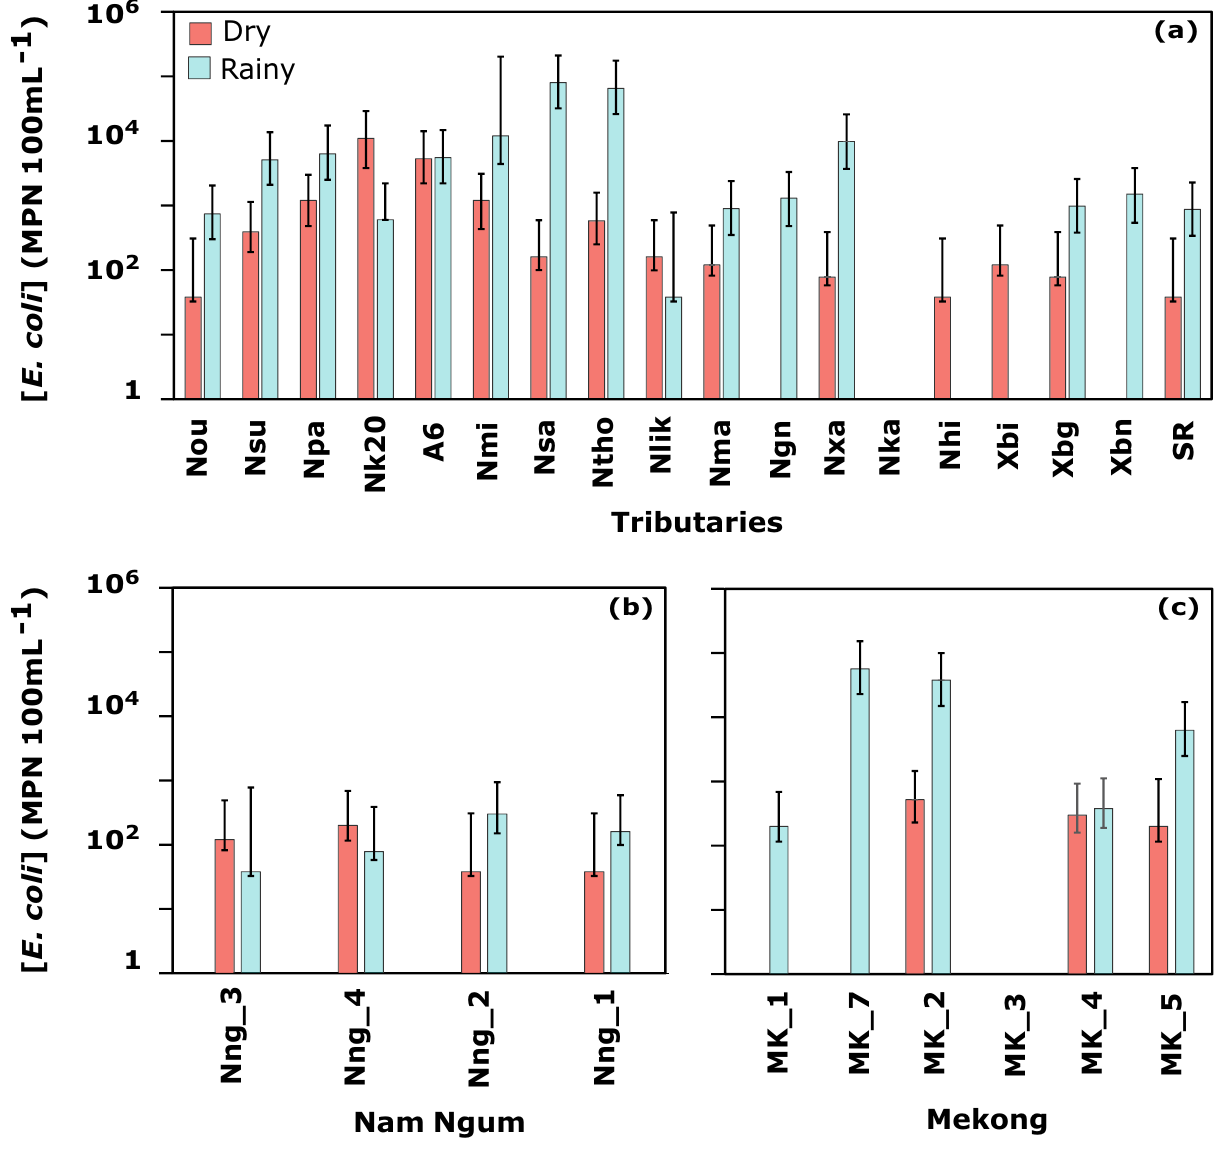
Figure 2. E. coli concentration with lower and upper 95% confidence limits ([ E. coli ], MPN 100 mL −1 ) in sampled watersheds of ( a ) Mekong tributaries, ( b ) Nam Ngum river, and ( c ) Mekong river across Lao PDR. Bars filled with orange represent concentrations during March 2016 (dry season) and bars filled with blue represent concentrations during July 2016 (rainy season). Sampling stations are classified from northern to southern Lao PDR. Figures generated with RStudio (version 1.2.1335; http://www.r-proje ct.org) and edited with Inkscape (version 0.92.4; https ://inksc